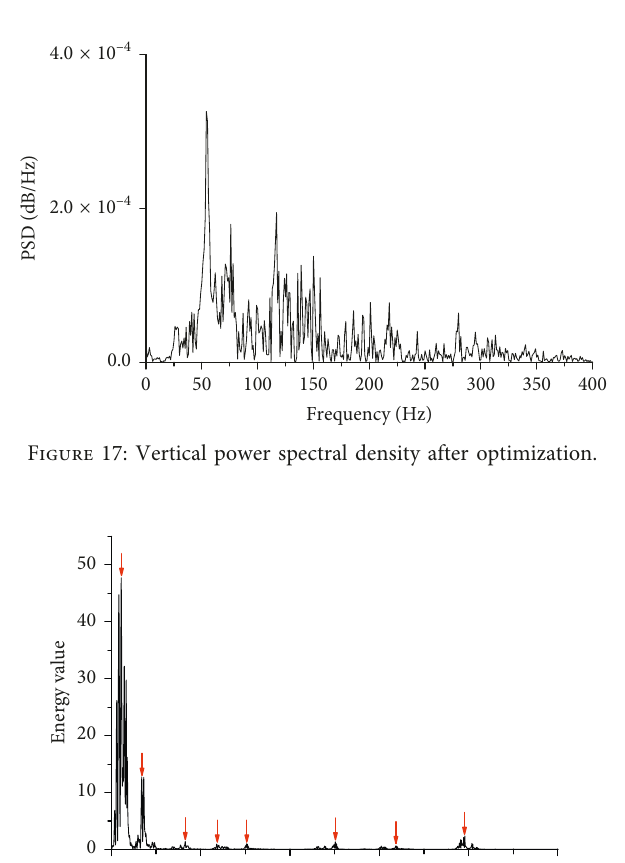
Figure 16: Vertical power spectral density before optimization.